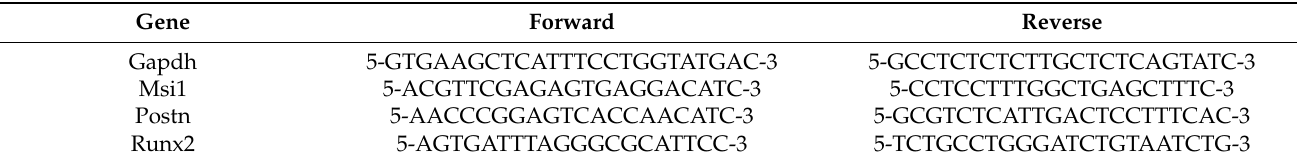
Table 5. Primer sequences for the mRNA evaluation of the specified